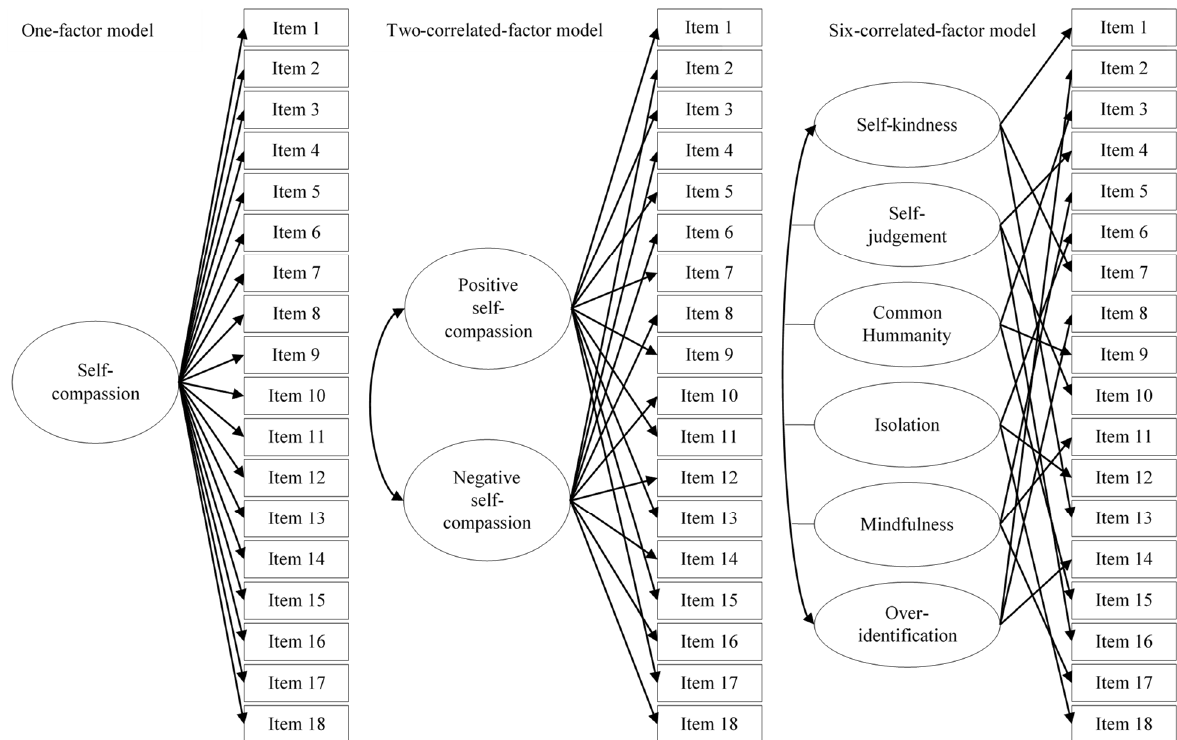
Figure 1. Competitive Confirmatory Factor Analyses for the SSCS–L.